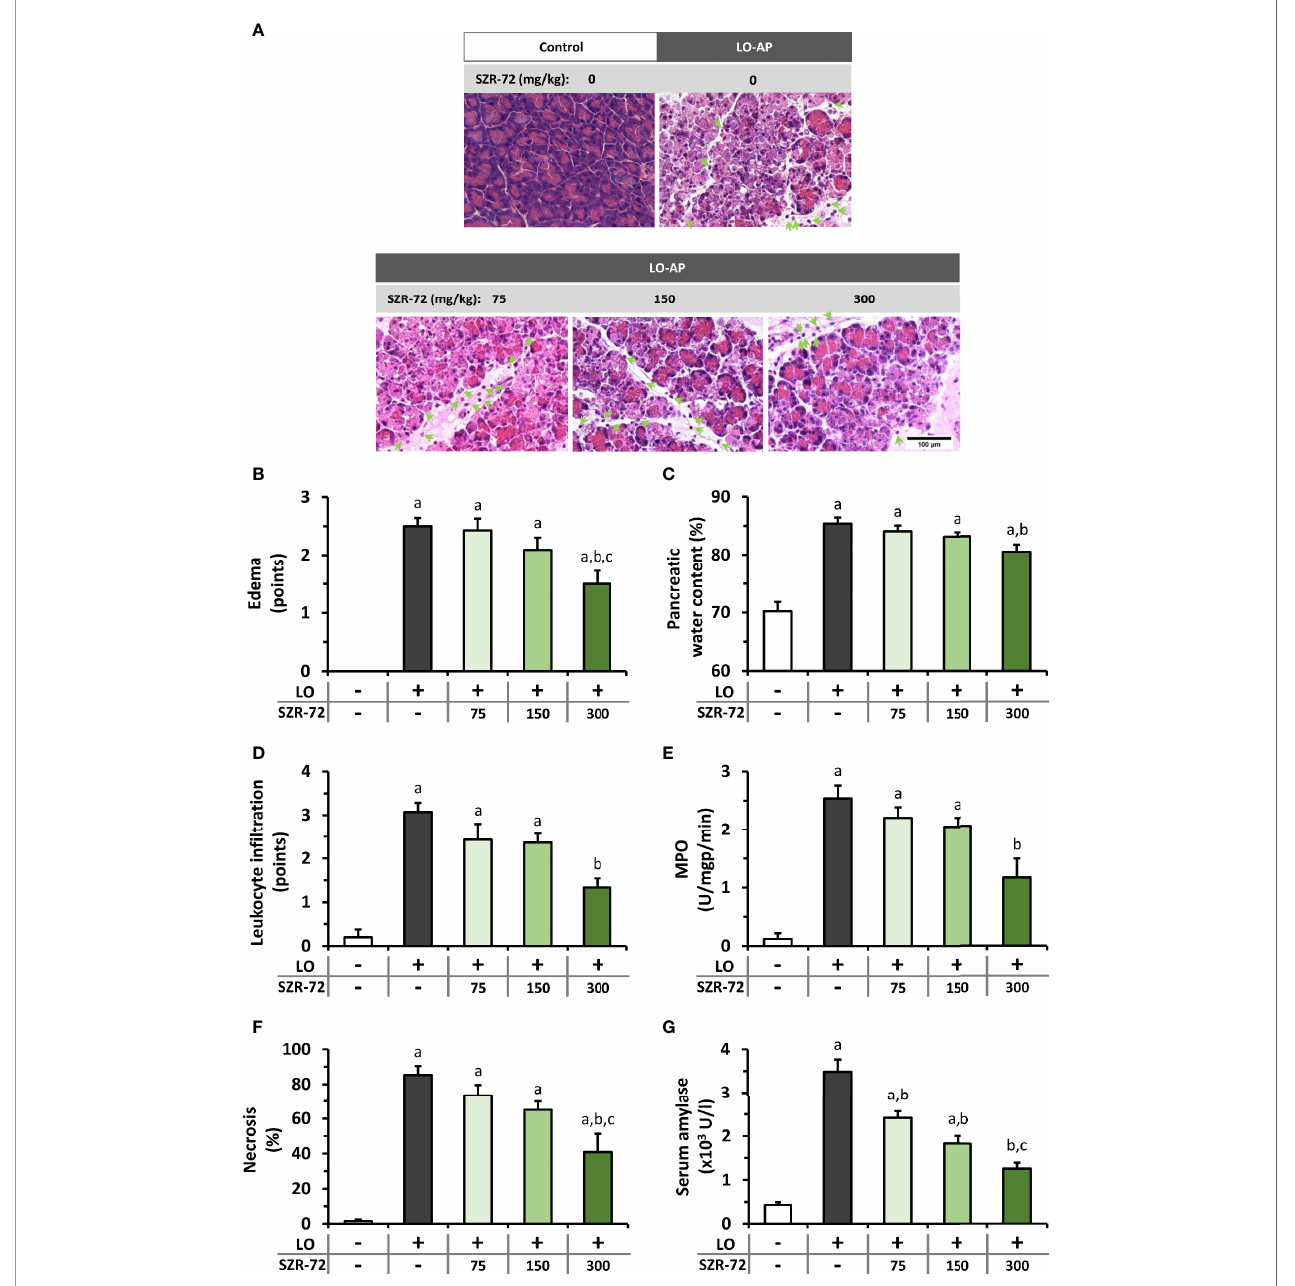
FIGURE 3 | The effects of SZR-72 on the severity of AP. (A) Representative histopathological images of pancreatic tissues of the treatment groups, arrows indicate neutrophil granulocytes. Bar charts show the extent of pancreatic (B) edema, (C) water content, (D) leukocyte in fi ltration, (E) myeloperoxidase (MPO) activity, (F) necrosis, and (G) serum amylase activity measurements. Values represent means with standard error, n=5-11. One-way ANOVA was performed followed by Holm- Sidak post-hoc test. Statistically signi fi cant differences (p<0.05) were marked with: (a) vs . control; (b) vs . LO; (c) vs . LO+75 mg/kg SZR-72. LO, L-ornithine-HCl; MPO,